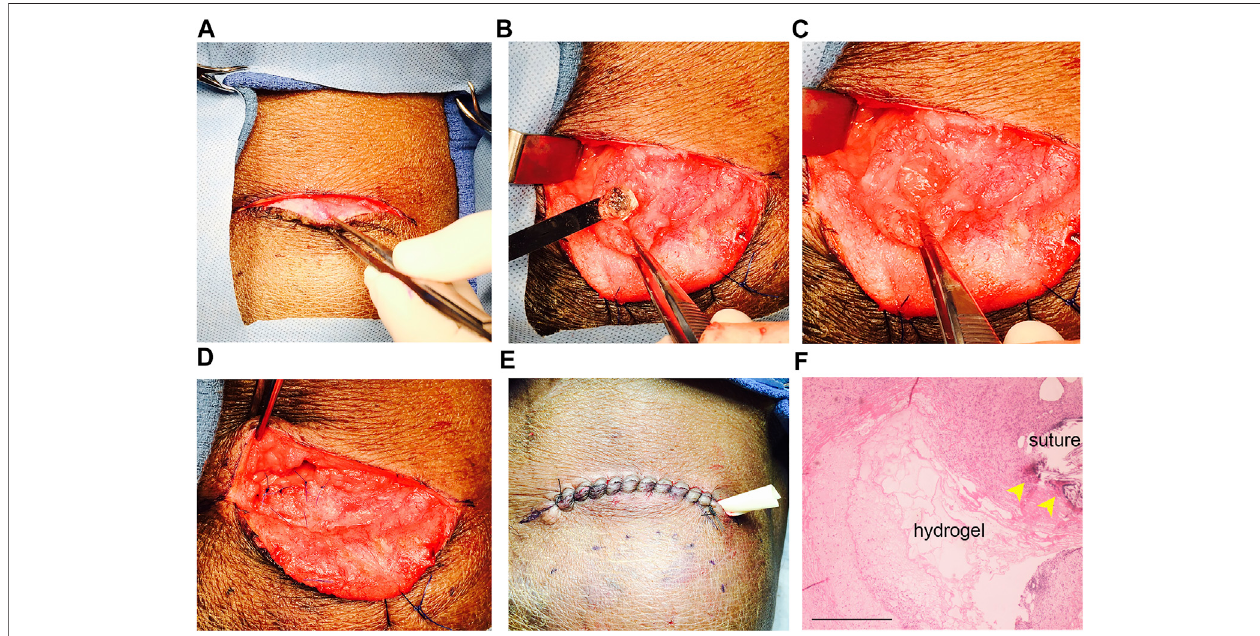
FIGURE 1 | Hydrogel biocompatibility study in the intact, non-irradiated miniswine model. (A) Incision site; (B) placement of acellular hydrogel (without the SIS membrane)intheuntreated parotidbed inasurgicallycreated pocketusingasterilespatula; (C) exposedhydrogelinthepocketbeforeclosure; (D) suturedpocketwith enclosed hydrogel implant; (E) sutured site of implantation after tissue closure with a ventral drain inserted; (F) H & E stained section of tissue removed after 1 week of implant. Note that hydrogel remnants are still detectable near suture sites (yellow arrows). Less in fl ammation surrounds the hydrogel than the sutures. Scale bar (cid:1) 500 µm.